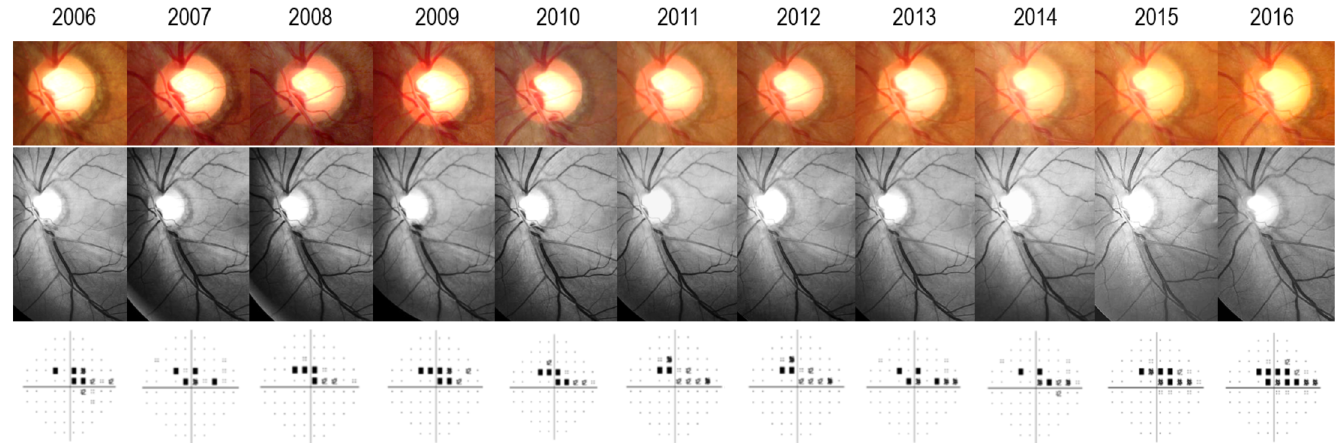
Fig 3. Representative case of disc hemorrhage (DH) in primary open-angle glaucoma (POAG) with mild-to-moderate myopia. The first row containsstereo disc photographs (SDPs) showingrecurrentDH in inferotemporal optic disc region(between2006 and 2010) and subsequent neuroretinal rim thinning. The second row containsred-free retinal nerve fiber layer (RNFL) photographyrepresenting gradual enlargement of RNFL defect 3.8 years after initial clinicaldetectionof DH (in 2010). The last row shows visual field progression manifested9.0 years followingthe initial DH (in 2015).